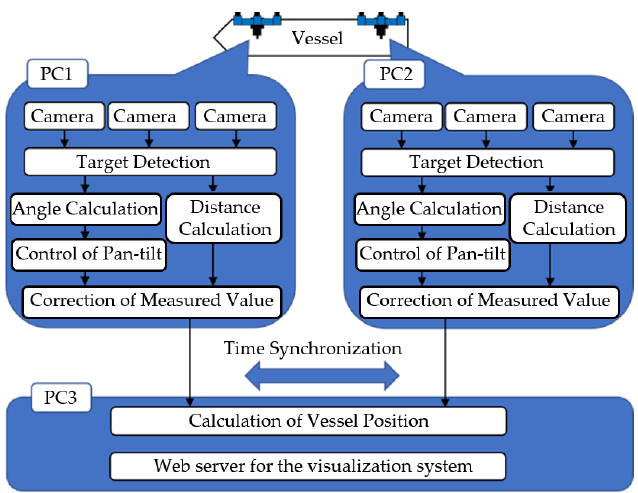
Figure 12. Each distance measurement system subdivided in the functional